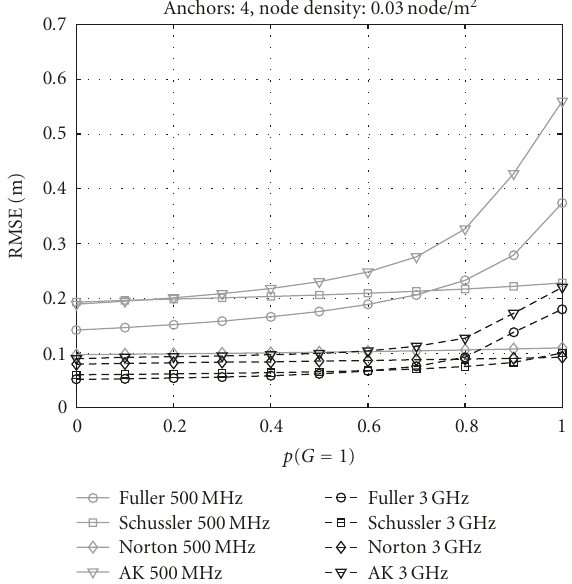
Figure 8: Localization performances as a function of p ( G = 1) for 500 MHz and 3GHz models.